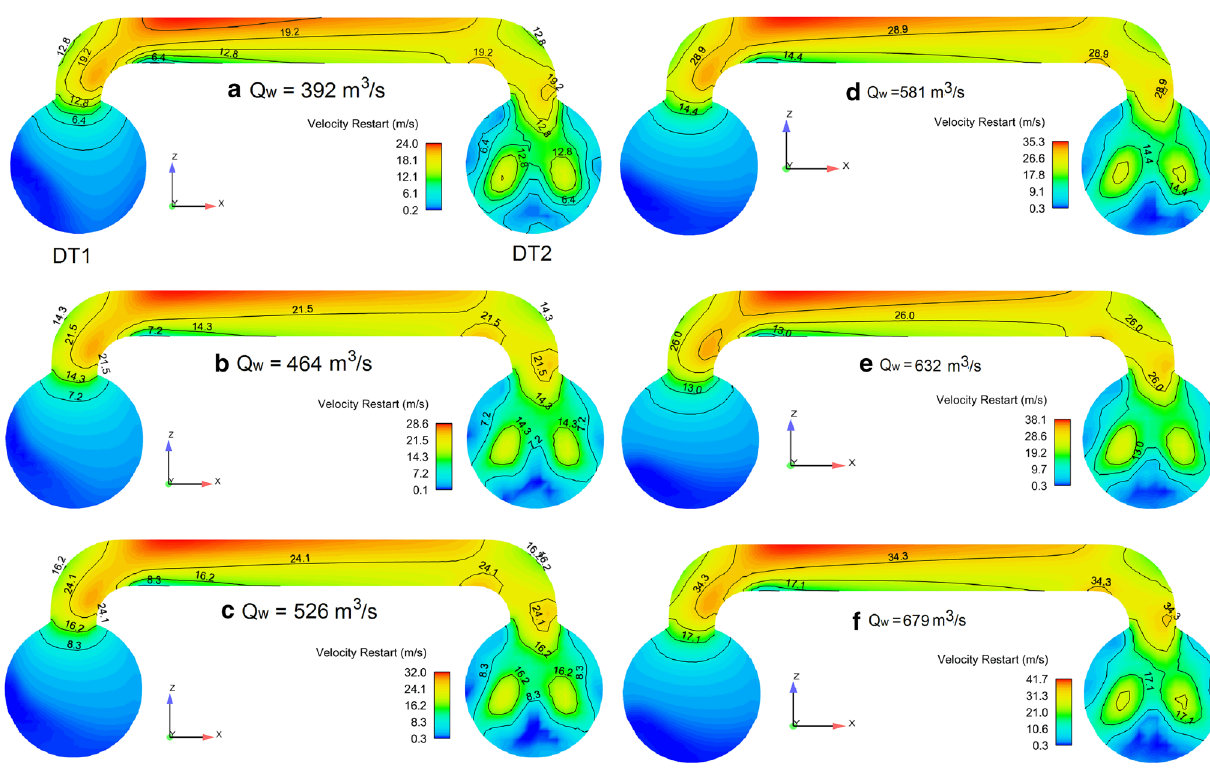
Fig. 11 Velocity contours of enhanced design no 1